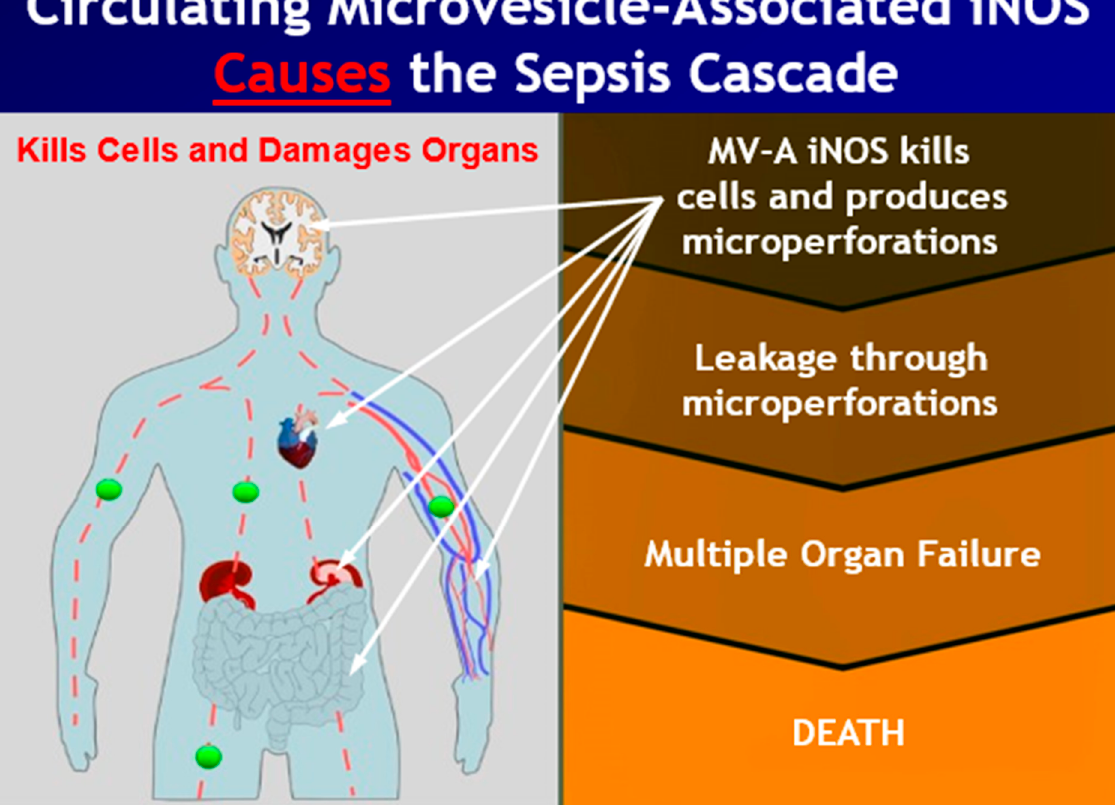
Figure 4. This illustration shows the causative role that microvesicle-associated iNOS (MV-A iNOS), shown as green balls, plays in sepsis. Once the MV-A iNOS is delivered as cargo contained in circulating microvesicles to receiver cells at distal sites in the body, the active iNOS enzyme is internalized into the receiver cells, where it produces toxic quantities of nitric oxide. This kills the receiver cell, which produces microperforations in barrier structures that then leak, and it also damages the myocardium of the heart, which leads to hemodynamic collapse and death.